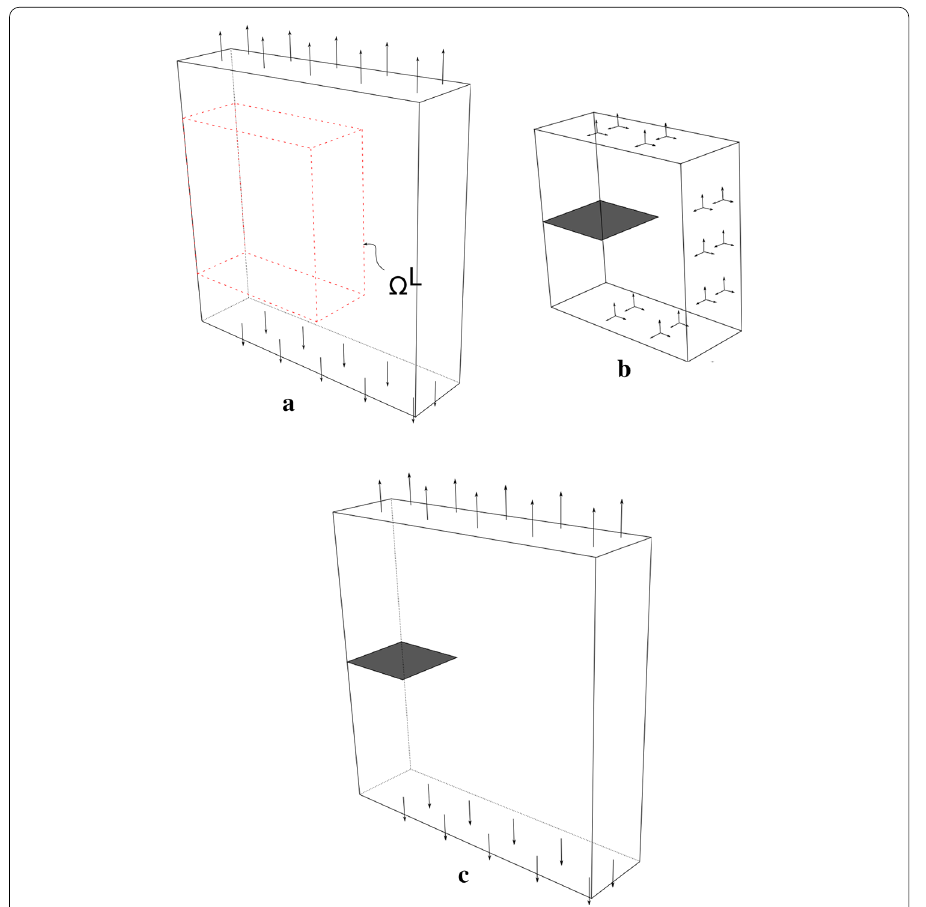
Fig. 10 GFEM gl steps for a 3-D edge crack— a initial global problem— b local problem— c enriched